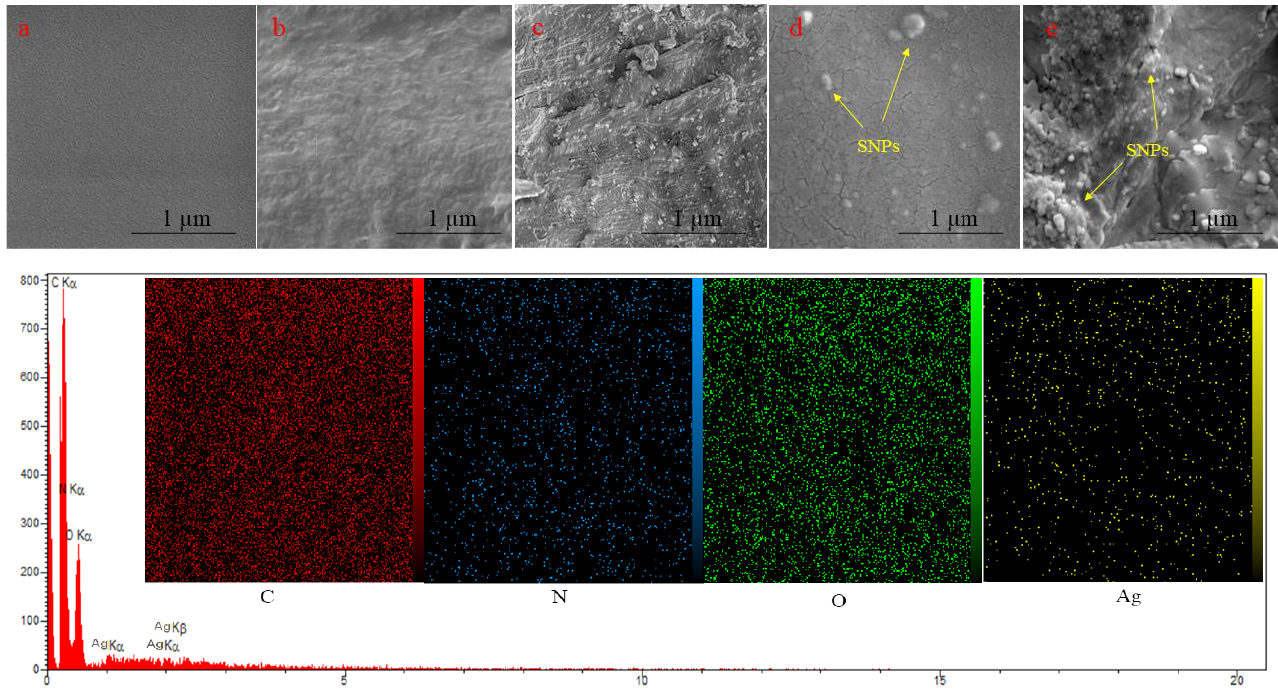
Figure 2. SEM-EDX image of ( a ) SPI, ( b ) SPI/0.25%PG, ( c ) SPI/1%PG, ( d ) SPI/PG/1%SNPs, ( e ) ( e ) SPI/PG/2%SNPs SPI/PG/2%SNPs films.